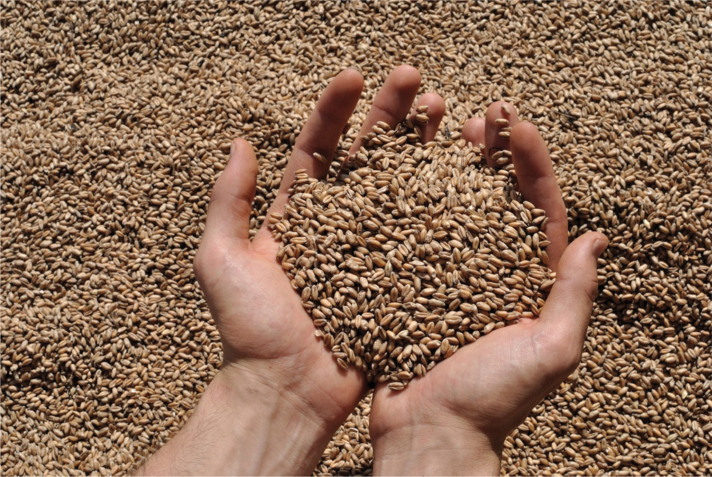
©Fotolia, Sergiogen